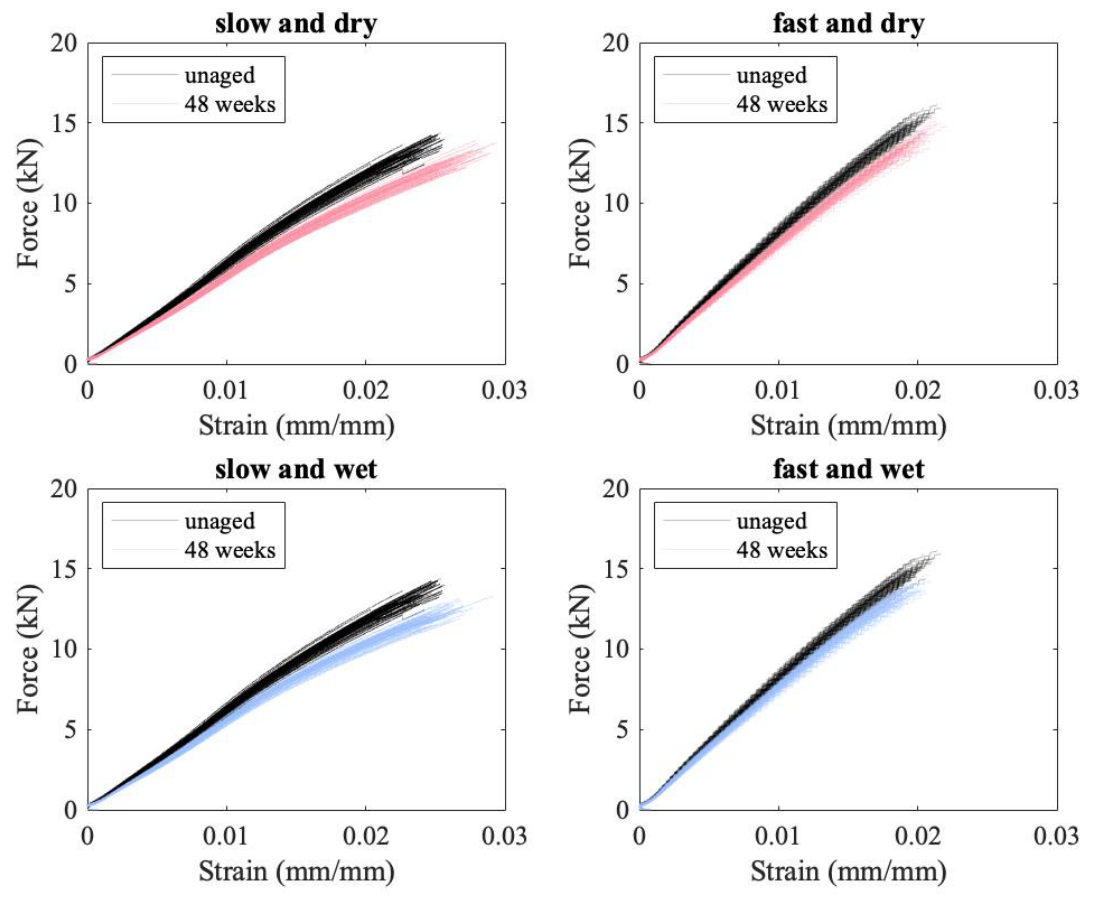
Figure 8. Load vs. strain curves for the unaged and most aged